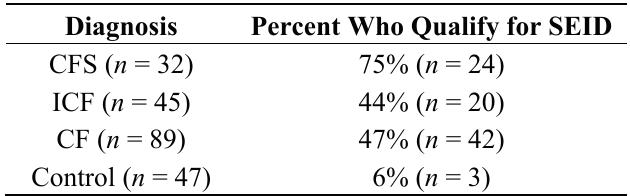
Table 3. Community Epidemiology database n =